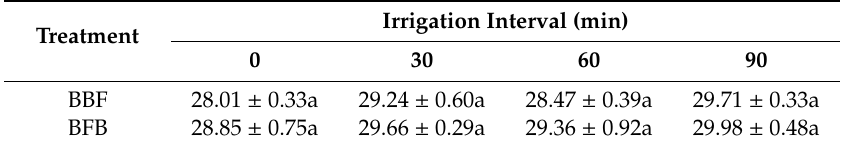
Table 2. Mean water content (%) in the silty loam at depths of 0–32 cm under di ff erent irrigation